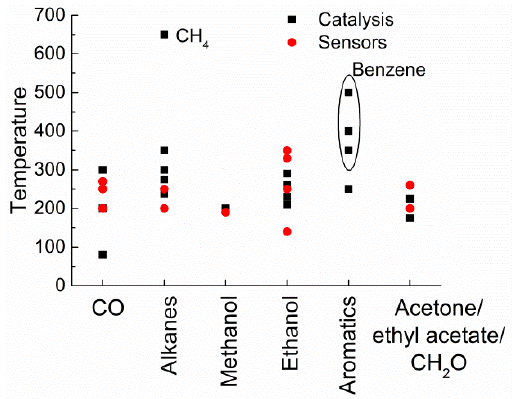
Figure 4. Best operating temperatures for the indicated sensing (best operating temperature and response tradeoff) and oxidation (lowest total combustion temperature) experiments over several perovskite materials. More points are present when an appreciable spread of the results was found. The references are reported in the discussion.